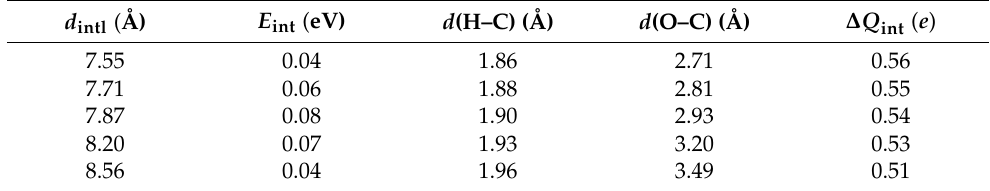
Table 5. Intercalation energy ( E int ) into BLG, distances from chlorosulfonic acid molecule to con- stituent MLG taking as a reference the H atom, d (H–C), and the O3 atom, d (O–C) (see Figure 2), and electron transfers from BLG to each acid molecule ( ∆ Q int ) for several interlayer distances ( d intl ) around equilibrium configuration. (Calculations for the low concentration